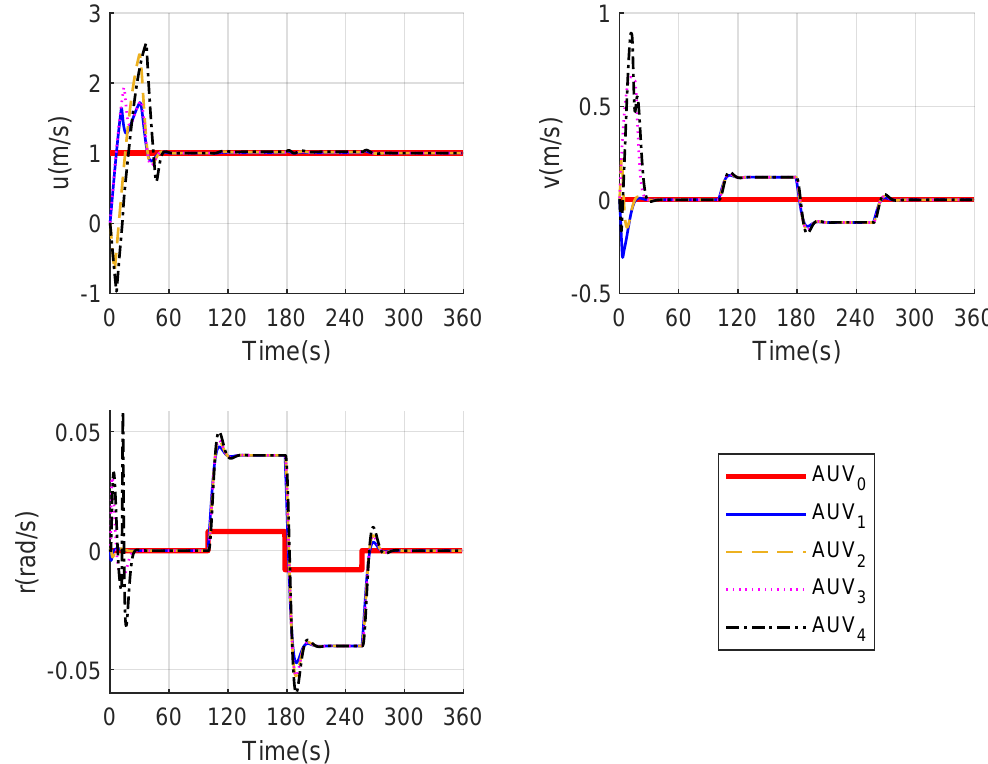
Figure 12. Velocity states of multi-AUV under alterable communication topology without